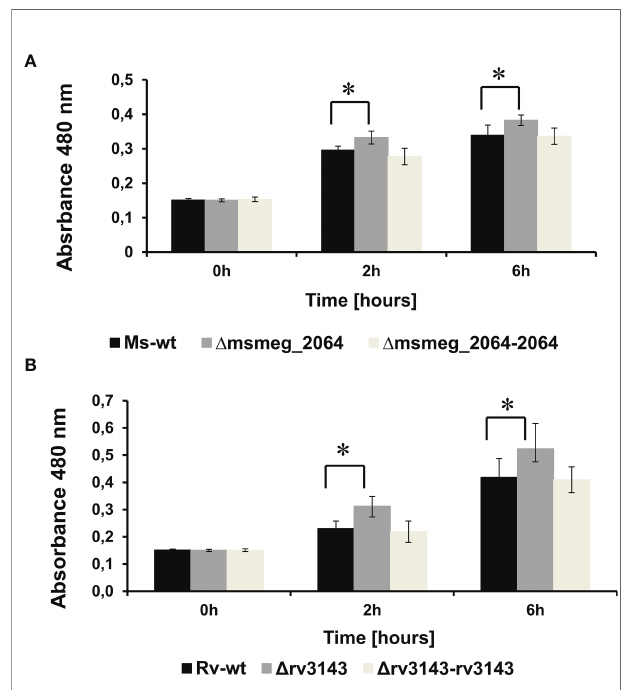
FIGURE 4 | Measurement of reduction rates of a redox indicator — TTC — in D msmeg_2064 Mycobacterium smegmatis (A) and D rv3143 Mycobacterium tuberculosis (B) strains. Absorbance values at 480-nm values are the means ± SDs from three independent experiments. Statistical signi fi cance was determined using Student ’ s t-test (A) (* p < 0.001); (B) (* p <